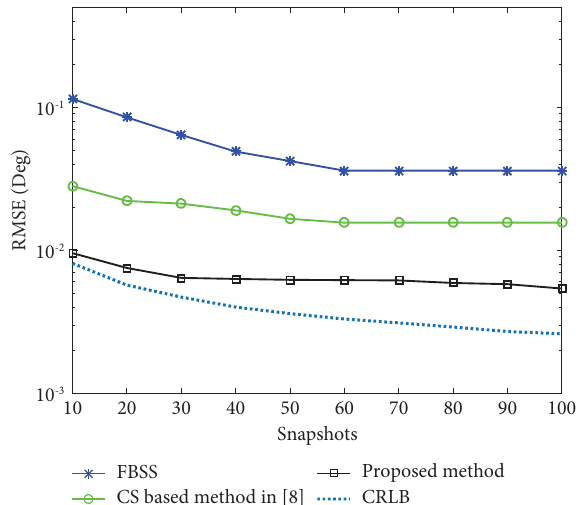
Figure 3: RMSE of the DOA estimation vs the snapshots.